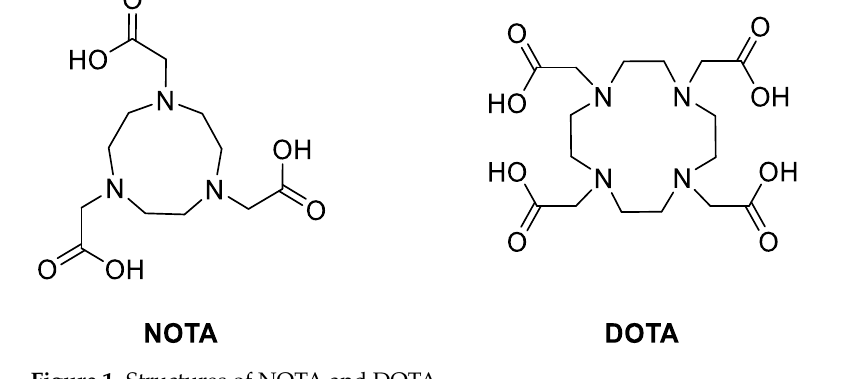
Figure 1. Structures of NOTA and DOTA.